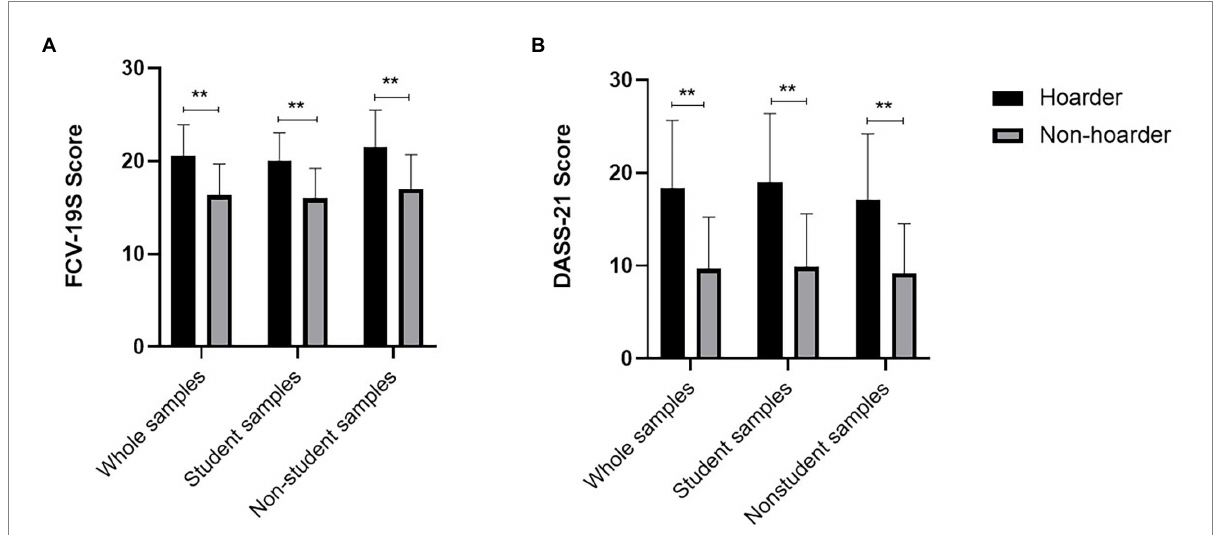
FIGURE 1 (A) Histogram model of the comparison of FCV-19S scores between hoarders and nonhoarders. (B) Histogram model of the comparison of DASS- 21 scores between hoarders and nonhoarders. The difference between the two scores was statistically significant (** p <